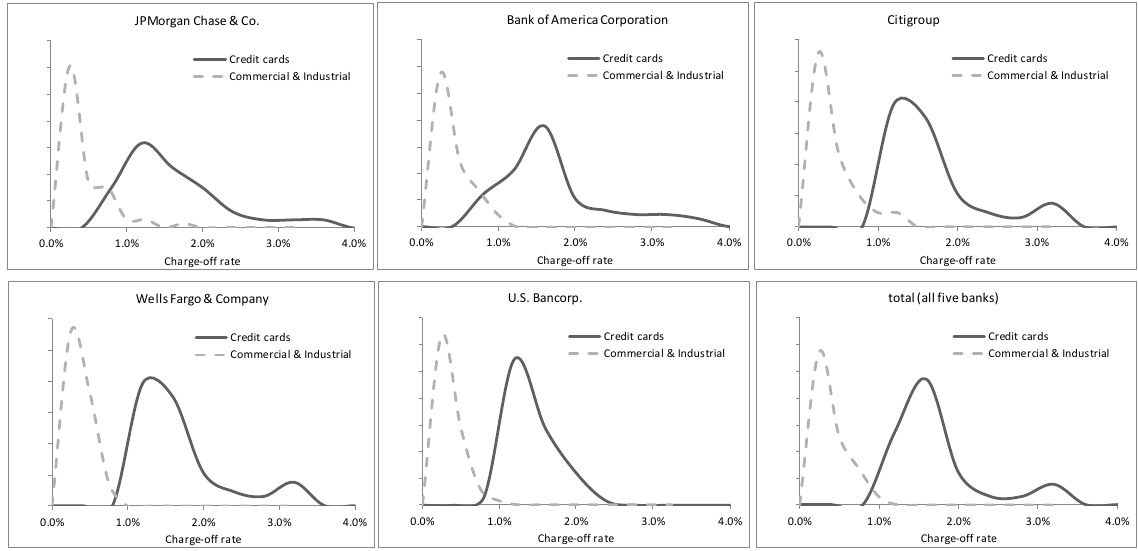
Figure 7. Charge-off rates’ density functions.